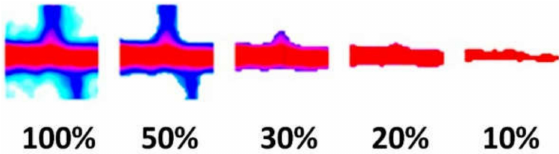
Figure 7. Intersection images preserving di ff erent pixel